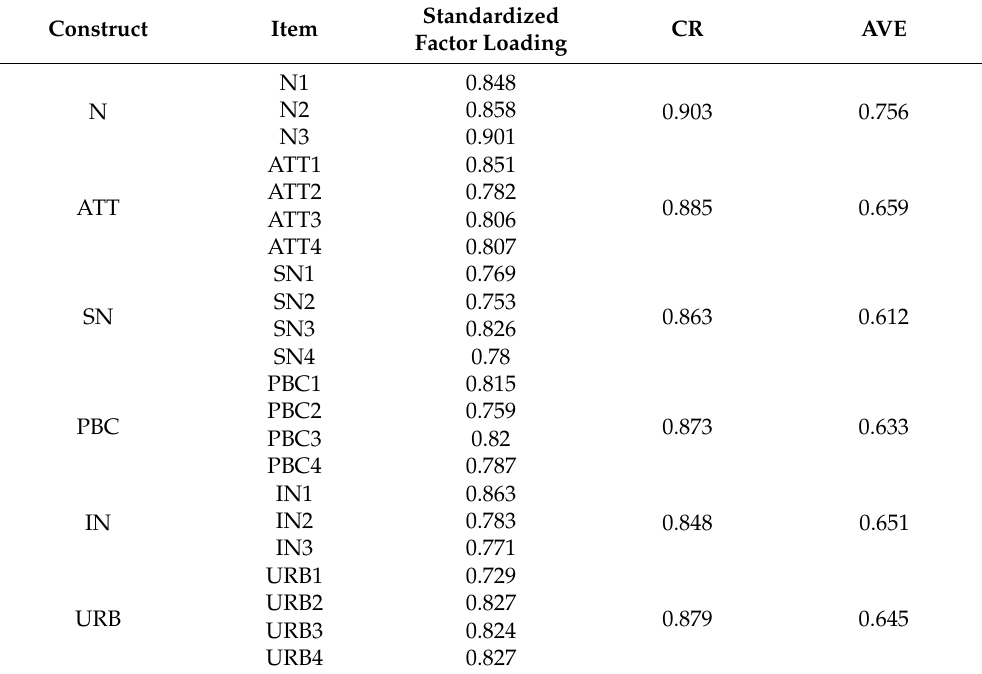
Table 4. Results of convergent validity.